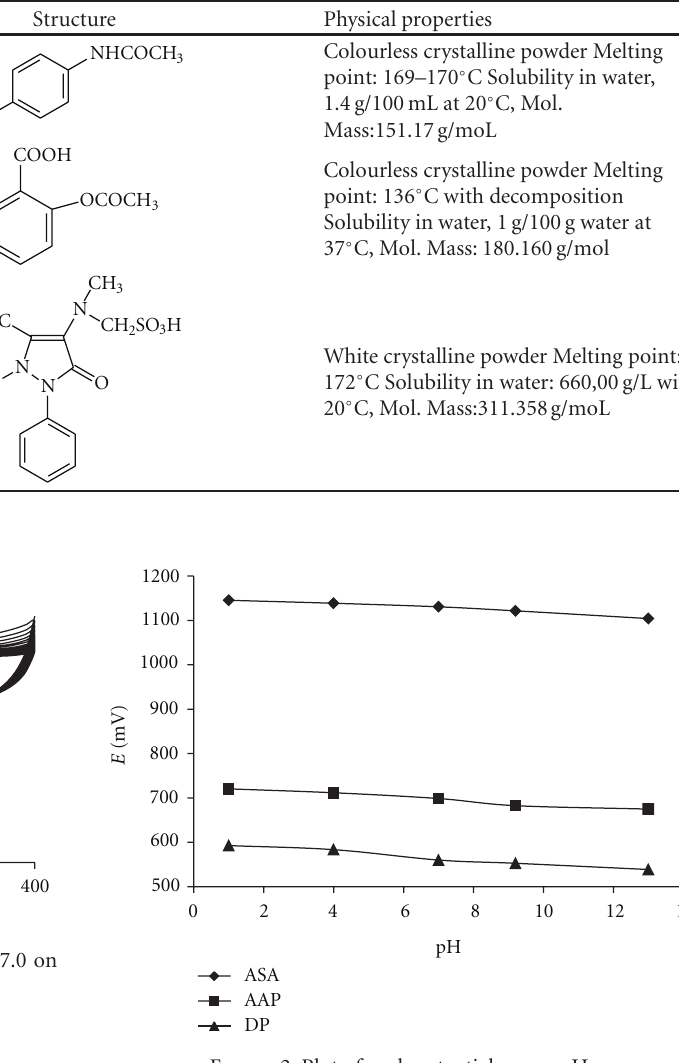
Figure 2: Plot of peak potential versus